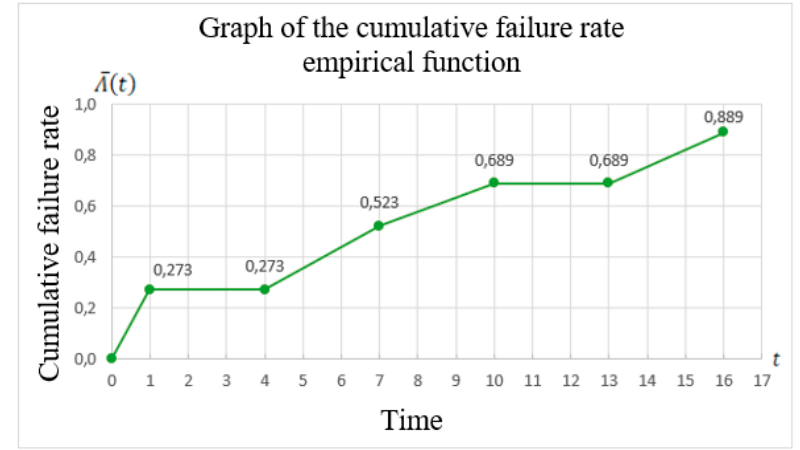
Figure 10. Leading empirical function waveform.